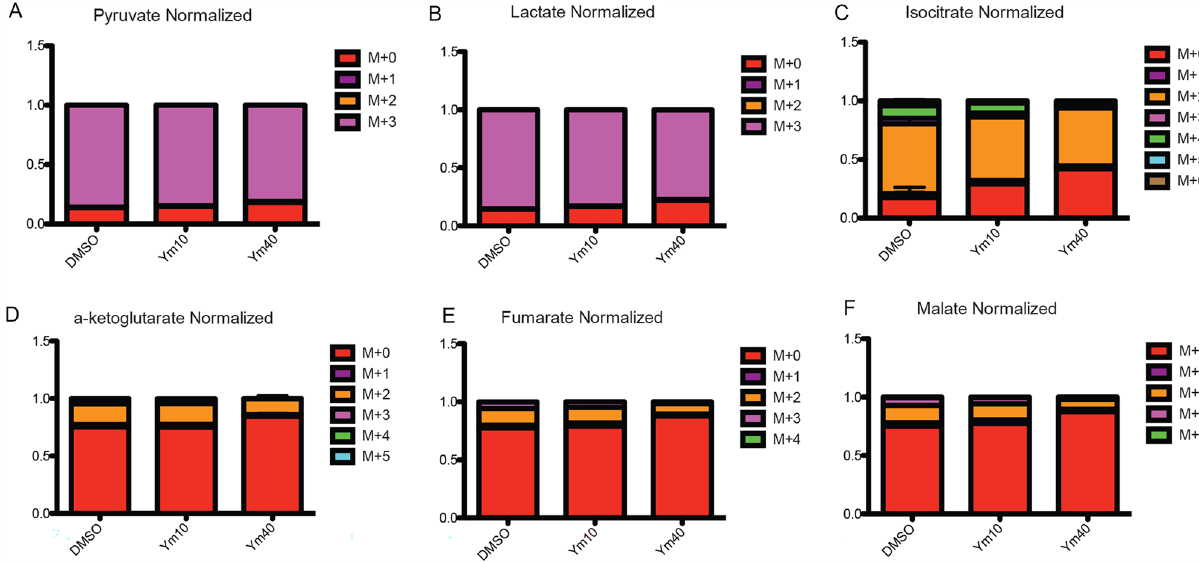
Figure 5. Ym155 decreases glucose 2-carbon transfer in the TCA cycle. H1299 cells were loaded with [U13C6] glucose for 2 h then treated with Ym155 for 3 h. ( A , B ) The number 3 carbons (M + 3) in glycolysis intermediates pyruvate and lactate was the same between Ym155 treated and control. ( D ) The TCA cycle intermediate isocitrate, alpha-ketoglutarate, fumarate, and malate had significantly lower M + 2 carbons in Ym155 treated cells compared to controls ( C – F